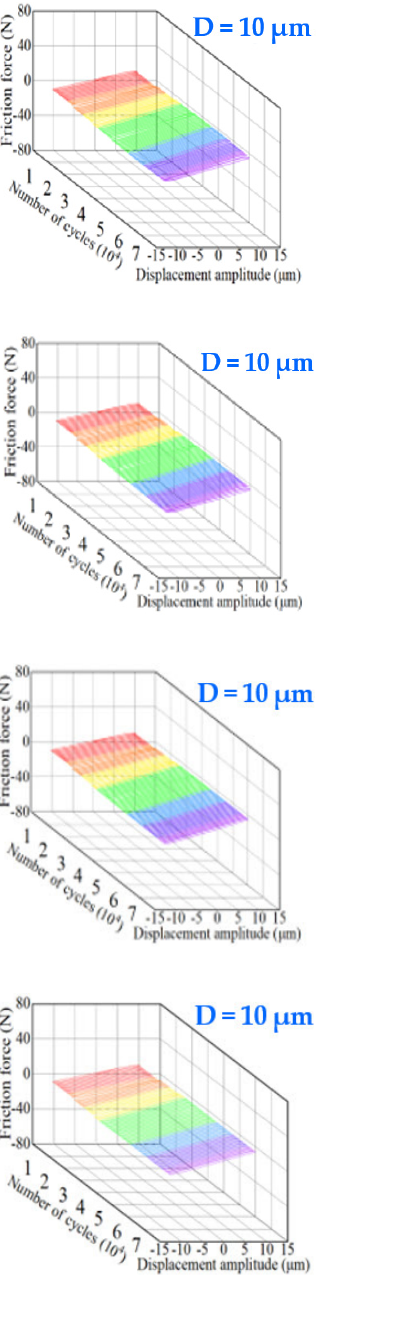
Figure 8. Typical 𝐹 𝑡 -D-N curve maps of GCr15 steel balls at different displacement amplitudes. Different colors represent the number of cycles in different stages, with one stage for every 10,000 cycles. ( a ) Untreated; ( b ) pro. in 6 h; ( c ) pro. in 12 h; ( d ) pro. in 18 h.